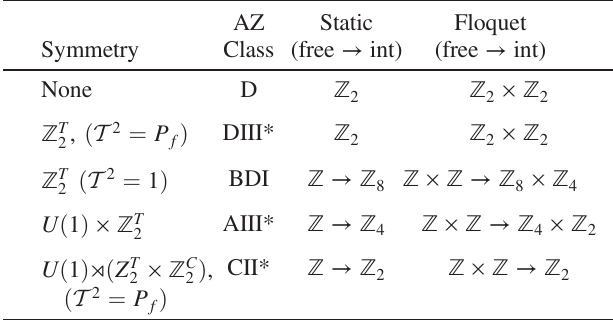
TABLE II. Classification of 1D fermionic Floquet SPTs. — Group structure of nontrivial topological classes for 1D fermionic systems with discrete on-site symmetries, listed by physical symmetry group and equivalent AZ class. C → C 0 indicates that the noninteracting classification C is changed by interactions to C 0 . AZ classes marked with * indicate symmetry groups that are incompatible with many-body localization and are therefore unstable to runaway heating in the presence of generic bulk